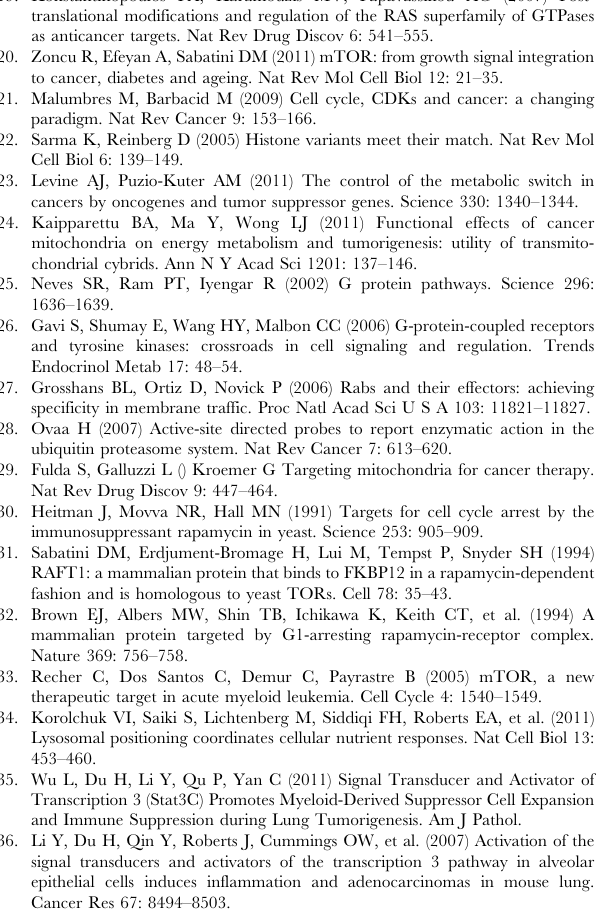
Table S1 Changes of histone related genes in MDSCs from the bone marrow of lal 2 / 2 mice.